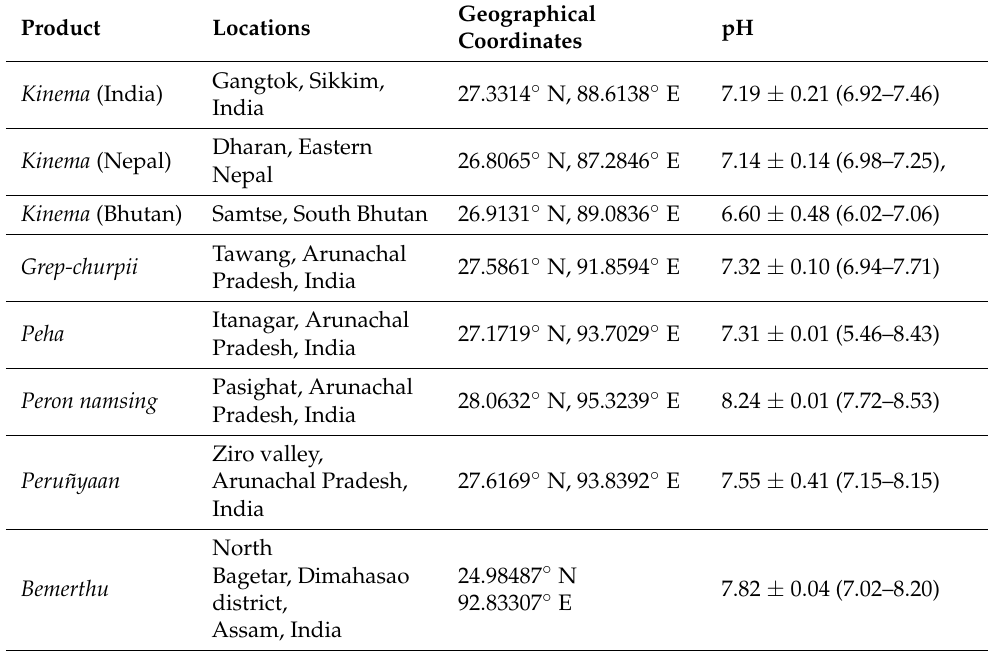
Table 1. Location of sample collection, geographical coordinates and pH of kinema, grep-chhurpi, peha, peron namsing and peruñyaan